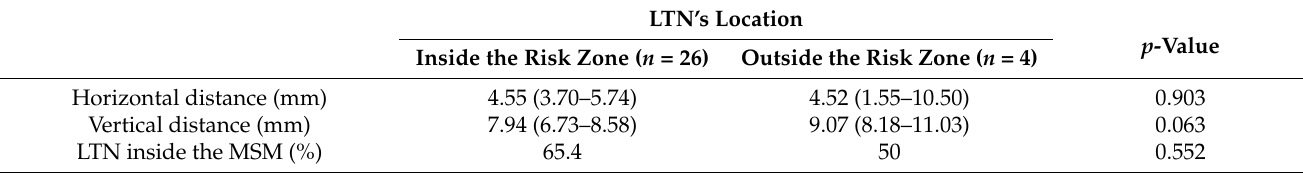
Table 3. The statistical analysis of the association between the long thoracic nerve’s locational relation to the C7 nerve root and middle scalene muscle and injury